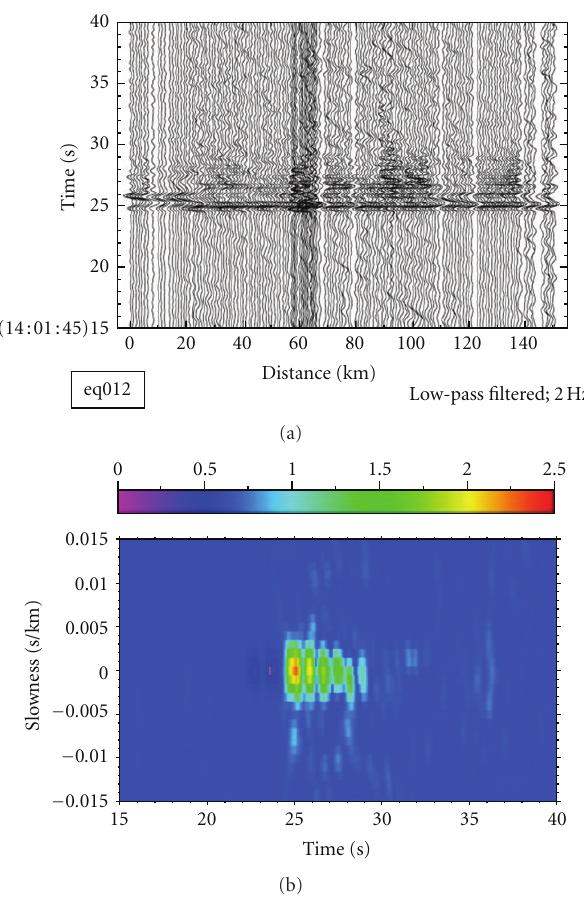
Figure 7: (upper) Time-expanded record section of the Kermadec Is. event (event#; eq012), which are aligned on the onset of the direct P and are 2.0 Hz low-pass filtered. The pivot station is located at 74km. The vertical time-window contains the direct P and the core-reflected PcP. (lower) Contour map of the phase-weighted- stacking (PWS) applied to all traces of upper in the same time- window (modified after